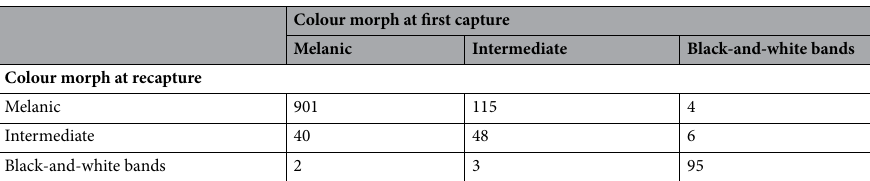
Table 1. Ontogenetic shifts in colour in individual turtle-headed sea snakes, Emydocephalus annulatus , based on records of snakes captured in multiple years. The table shows numbers of records, in some cases including multiple successive recaptures of the same